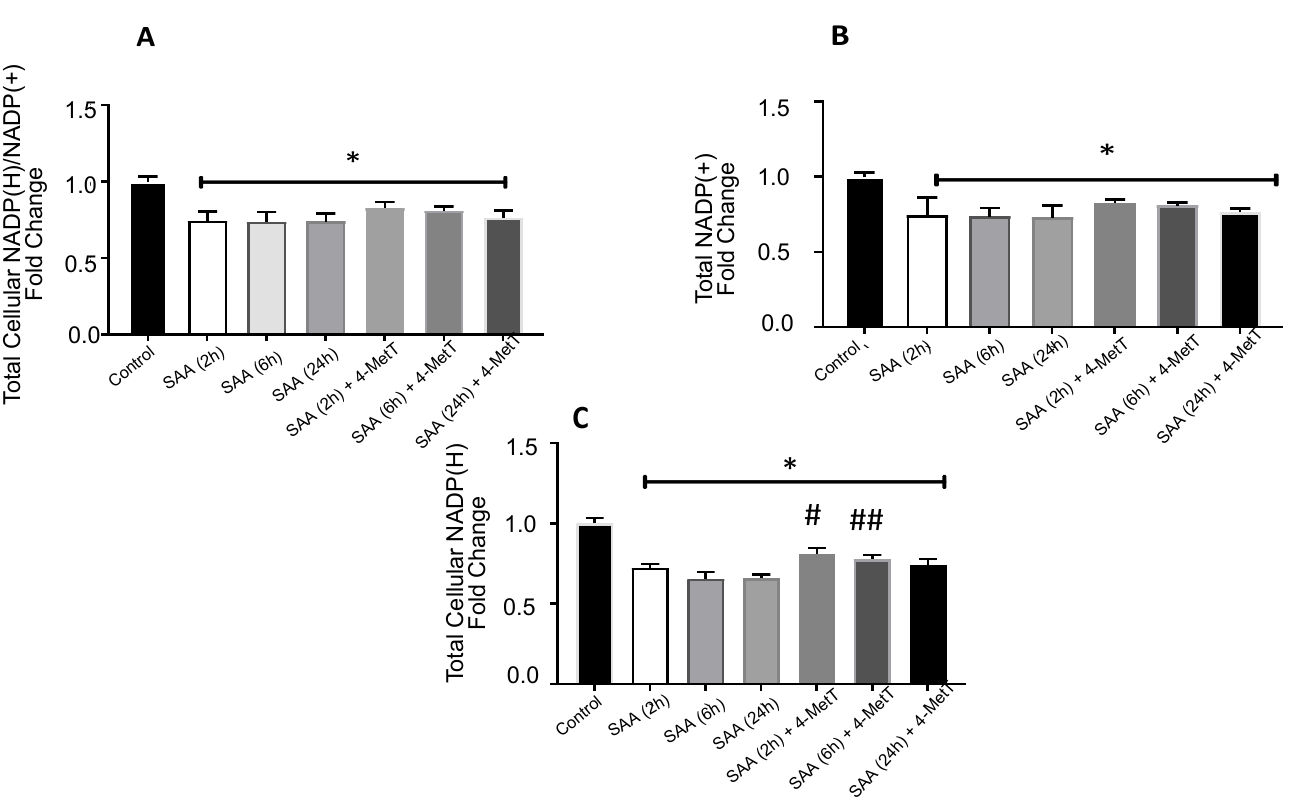
Figure 9. Effect on the NADP(H)/NADP(+) system in response to SAA and 4-MetT in HAEC. ( A ). Ratio of NADP(H): NADP(+) ( B ). Individual NADP(+) ( C ). Individual NADP(H). n = 3 SAA (2 h), SAA (2 h) + 4-MetT, n = 6 all other groups. * Different to control in the absence of SAA; * p < 0.0001. # , ## Different to SAA-treatment group, p < 0.005.